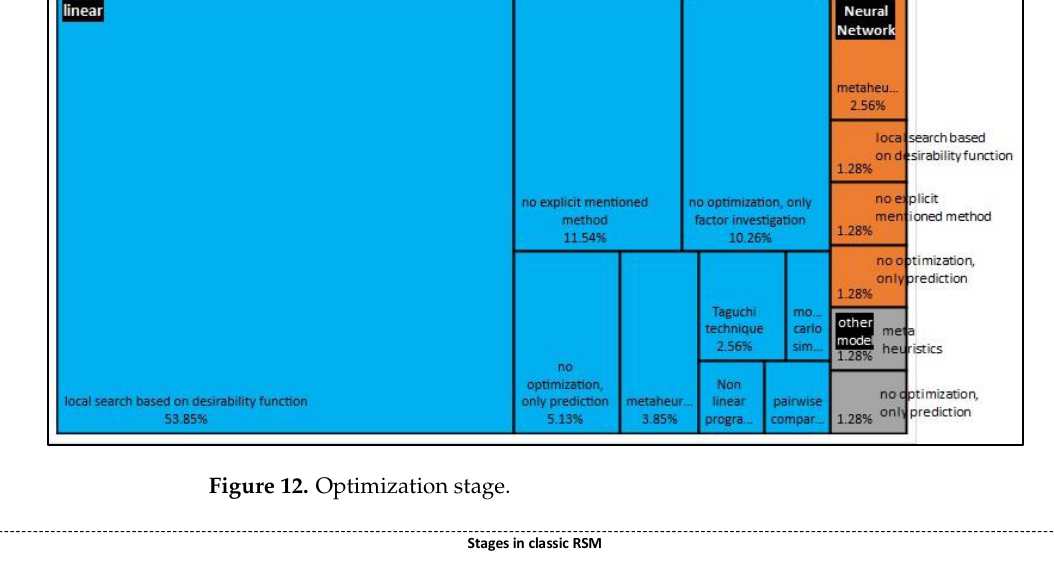
Figure 12. Optimization stage.